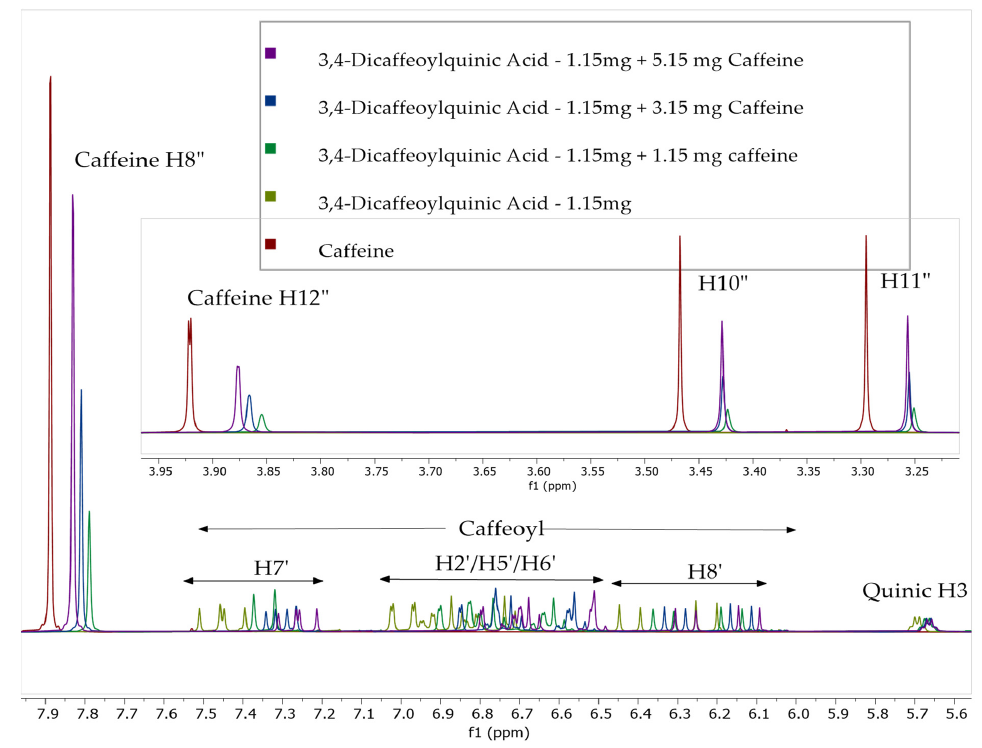
Figure 6. Superimposed 1 H NMR spectra of 3,4-diCQA (3.4 mM) with sequential addition of caffeine (0 mM, 9 mM, 27 mM, and 45 mM) .